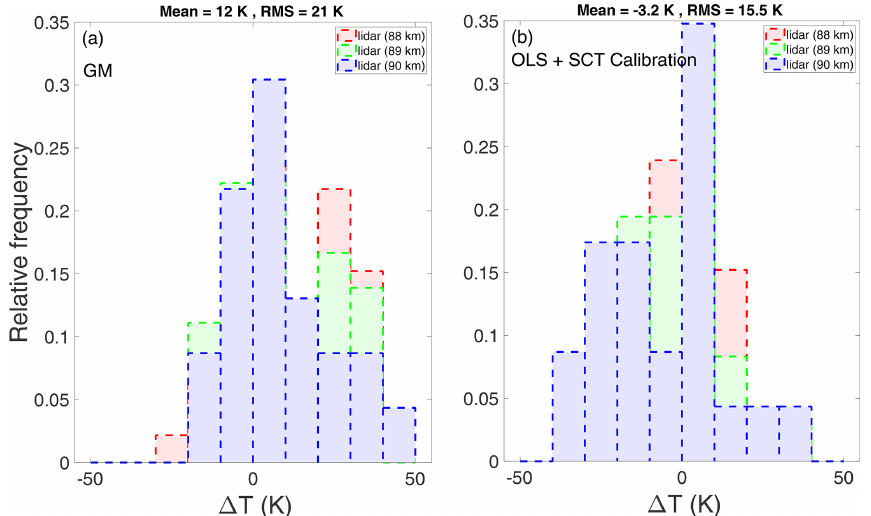
Figure 6. Difference between MR temperatures and lidar data for (a) the GM solution at contour level 0.4 and (b) SCT calibration applied to OLS estimate of β d . MR temperatures are shown in Fig. 5. OLS